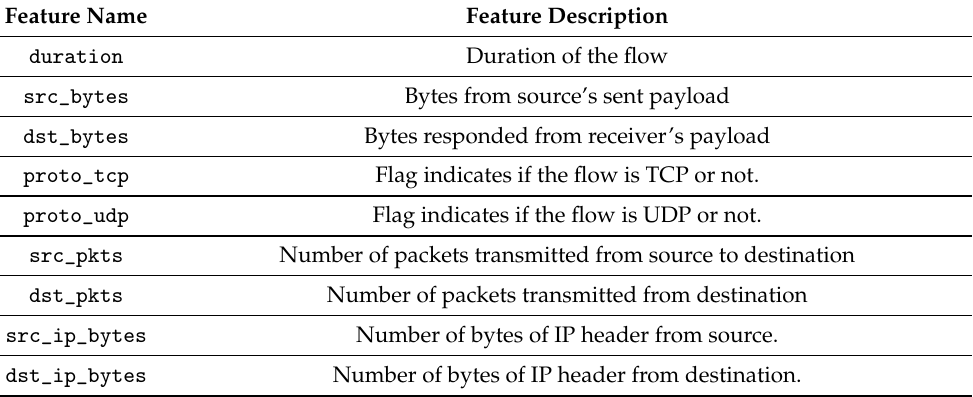
Table 4. The final used features after encoding.